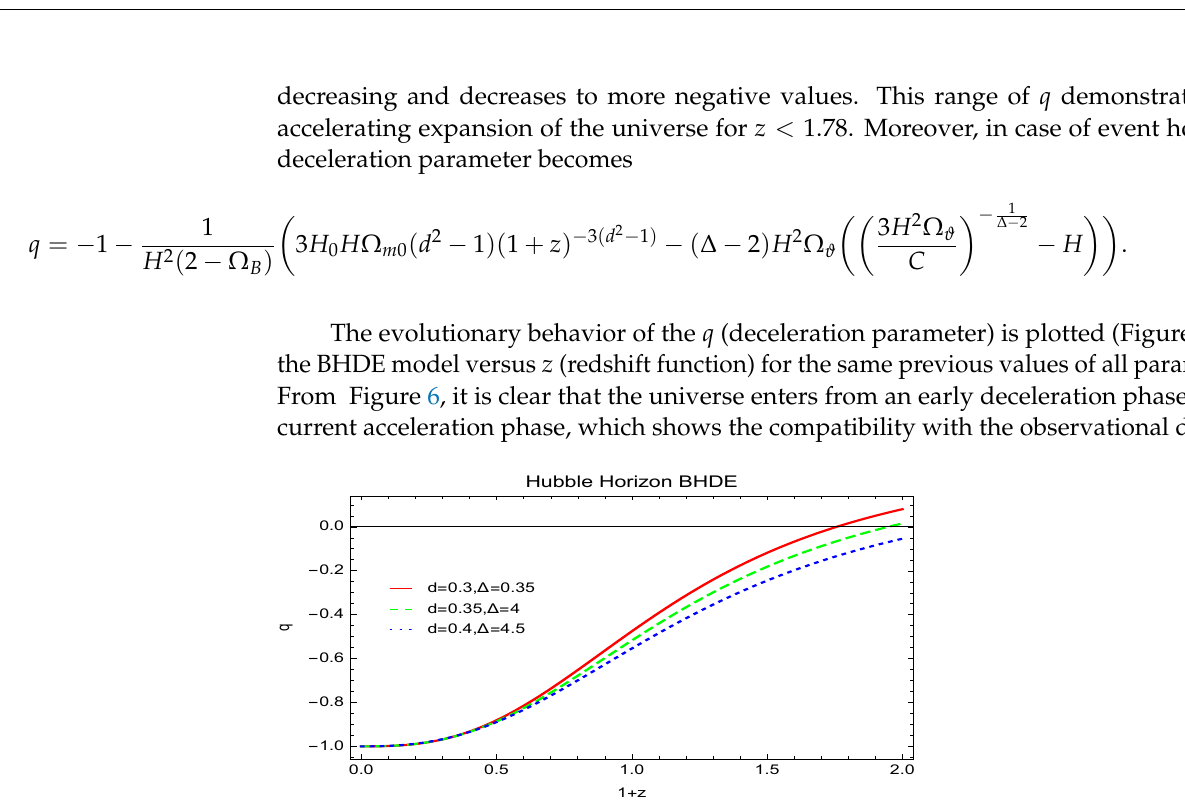
Figure 5. The evolutionary behavior deceleration parameter q versus redshift parameter 1 + z for interaction BHDE model with Hubble horizon for GDP braneworld cosmology.